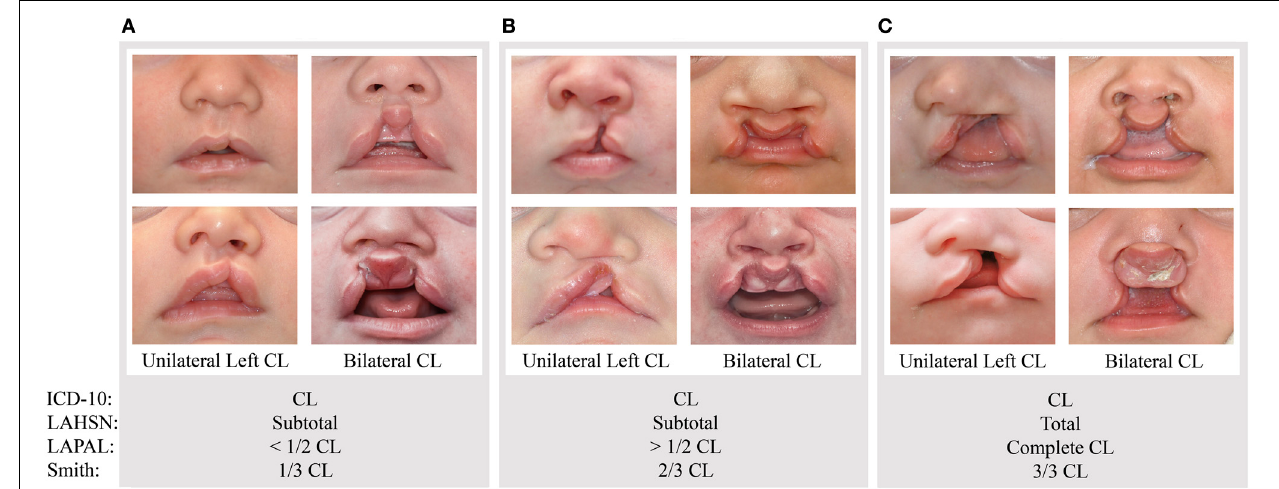
FIGURE 1 | Example rankings of varying unilateral left and bilateral phenotypic presentations based on subjective interpretations of the ICD-10, LAHSN (Koch et al., 1995), LAPAL (Liu et al., 2007), and Smith’s modification of Kernahan’s Striped “Y” (Smith et al., 1998). A cleft from Group (A) would be classified as a unilateral or bilateral